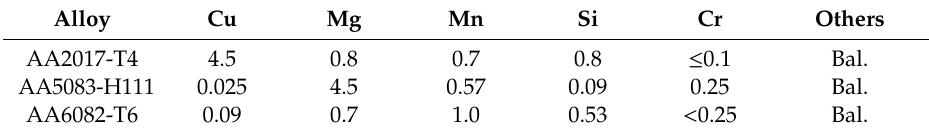
Table 1. Chemical composition of the base materials (wt.%).